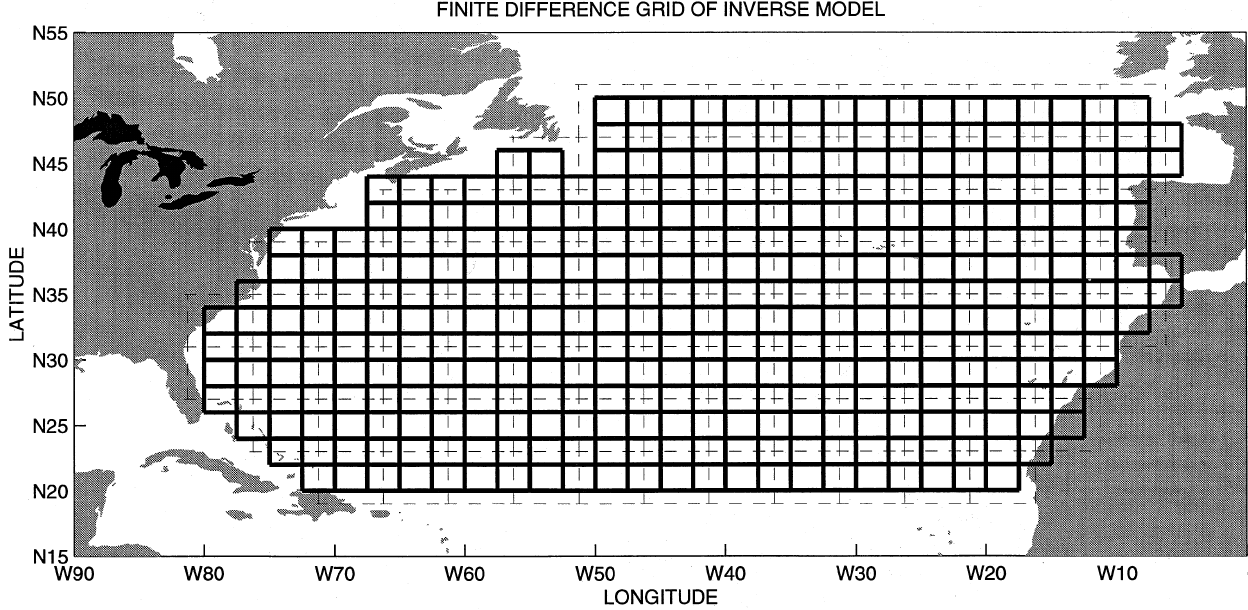
Fig. 1. The solid lines represent the 2.5 (cid:176) longitude (cid:180) 2 (cid:176) latitude density grid of the inverse model. The thin dashed lines represent the 5 (cid:176) longitude (cid:180) 4 (cid:176) latitude grid used to compute the altimetric estimate of mean dynamic topography (Sect.